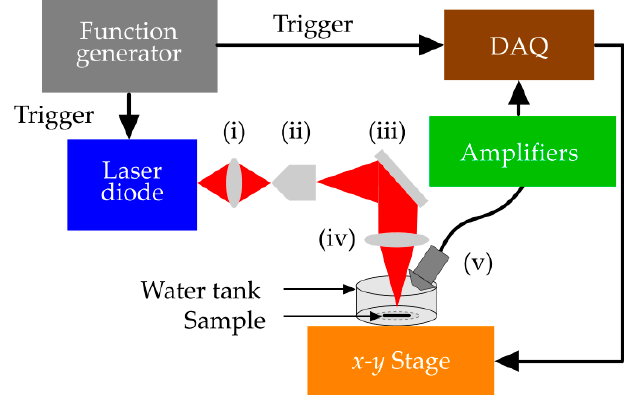
Figure 2. Schematic of a low-cost photoacoustic microscopy setup., (i) convex lenses (focal length of 100 mm), (ii) objective lens, (iii) mirror, (iv) convex lens (focal length 60 mm), and (v) unfocused ultrasound transducer.